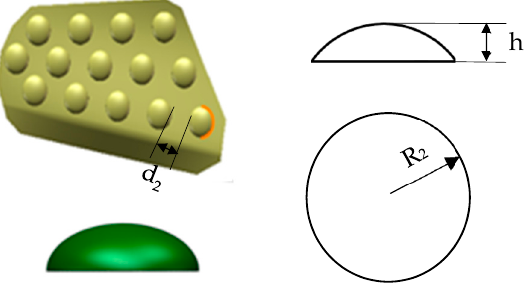
Figure 3. The convex hull structure of the wing plate.